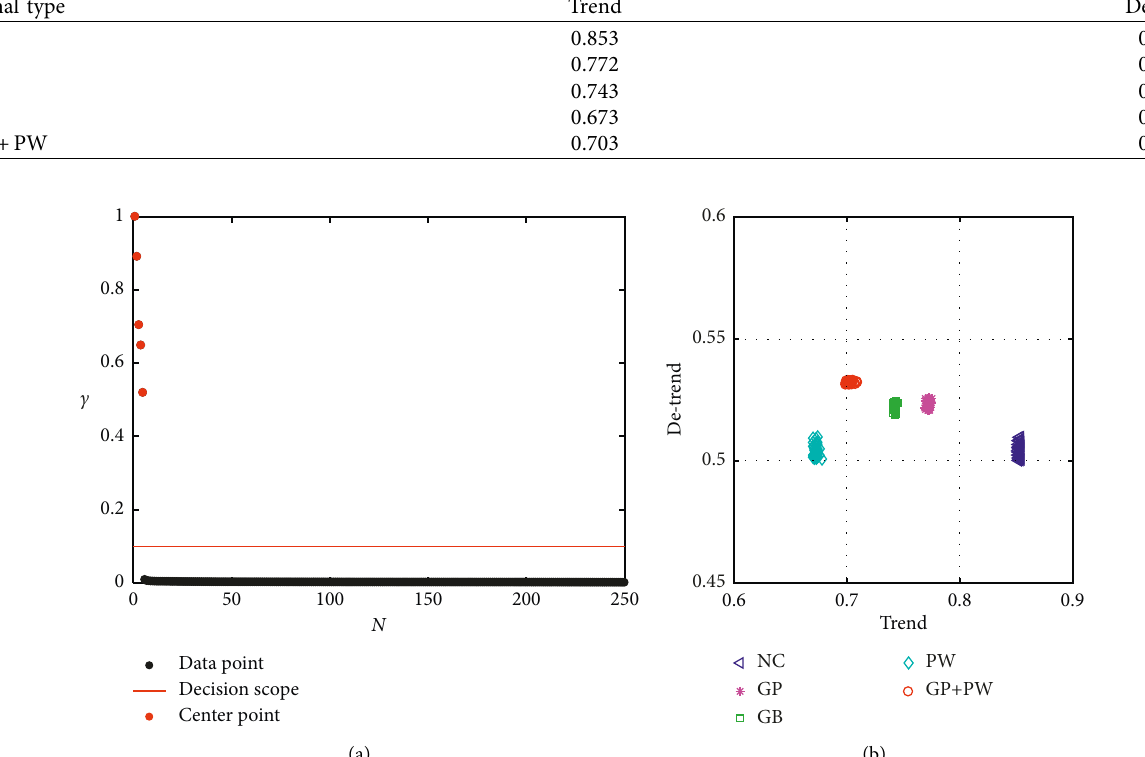
Figure 13: The vibration signal waveform of the gearbox under various states: (a) NC; (b) GP; (c) GB; (d) PW; (e) GP+ PW. Table 6: The FDE of trend and detrend of the gearbox under various states. Signal type